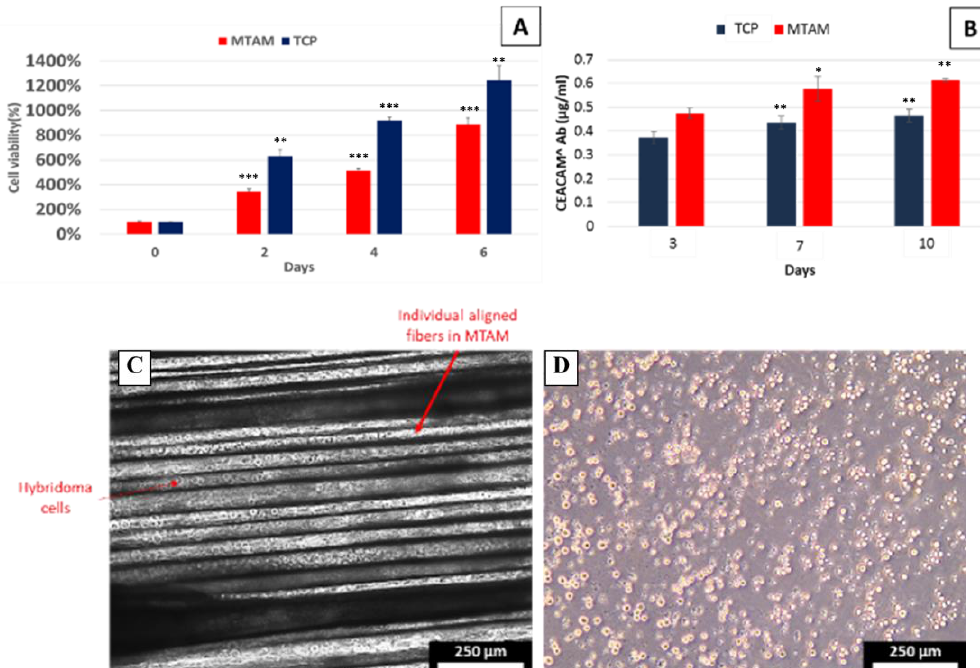
Figure 2. Cell viability of hybridoma cells cultured on TCPs vs. MTAMs ( A ) and CEACAM6 antibody levels produced by hybridoma cells when cultured on TCPs vs. MTAMs ( B ). Evidently, the higher levels of CEACAM6 antibody was registered by the hybridoma cells cultured within MTAMs as opposed to those cultured on standard TCPs. The antibody levels also do not directly correlate with the higher cell viability of hybridoma cells cultured on TCPs (A), and this was possibly substrate (MTAM) induced, since all other parameters were fixed. Optical image of hybridoma of day 6 encapsulated within MTAMs ( C ) within the respective lumens of MTAMs and hybridoma cultured on TCPs ( D ).